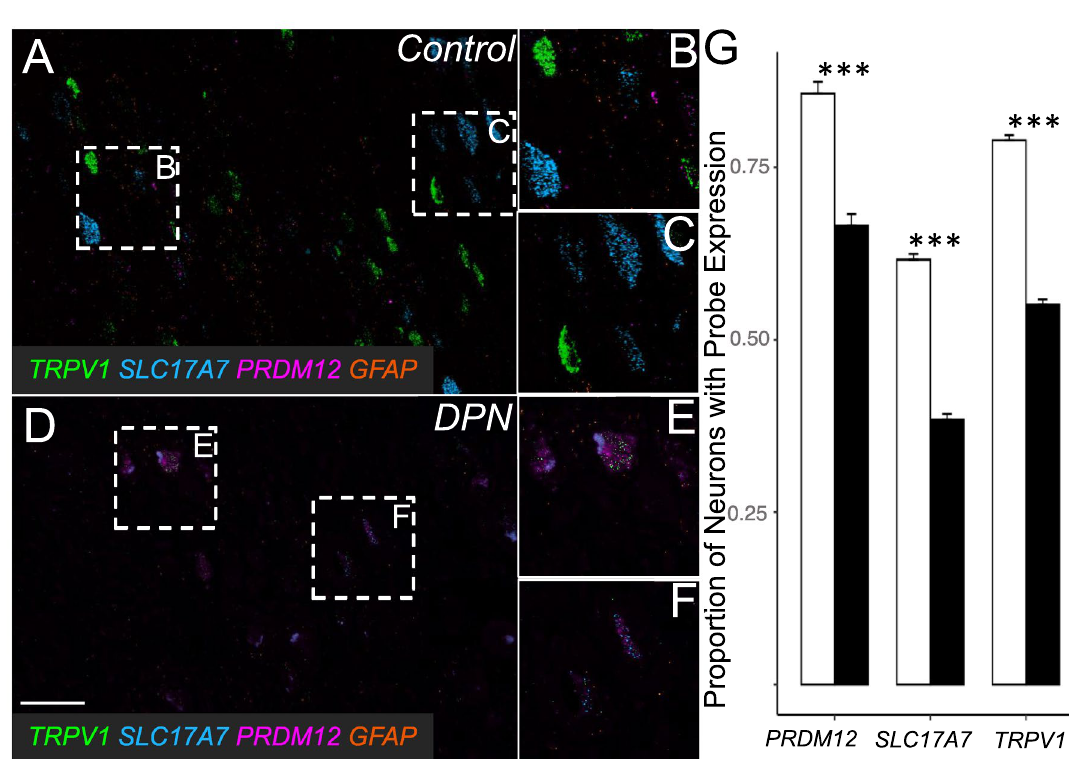
Figure 5. Representative images and comparison of RNAscope data: RNAscope data confirms a loss of neuronally related genes as noted in RNA-seq results by demonstrating a decrease in the proportion of neurons expressing each neuronal probe. ( A ) DRG of non-diabetic individuals displayed ( B ) small diameter TRPV1 positive neurons and ( C ) larger diameter SLC17A7 positive neurons. ( D ) DRG of DPN individuals had decreased proportions of neurons expressing all three probes, while still containing expected neuronal subtypes such as ( E ) small TRPV1 positive and ( F ) larger SLC17A7 positive neurons. Scale bar = 100 µm. ( G ) Differences in proportion of neurons expressing each RNAscope between control and DPN tissue were significant at the ***p < 0.0001 level, according to the Cochran-Mantel–Haenszel Test ( TRPV1 and SLC17A7 ), and Fisher’s Exact Test ( PRDM12 ). Each probe was significantly downregulated, evidence of a loss of neuronally related gene expression in DPN DRG. Data is shown graphically as mean and standard error. The downregulated expression of these three neuronal markers coincides with the neuronal loss seen histologically. Although dedifferentiation could cause a loss of TRPV1 + and SLC17A7 + neurons, most neurons were still labelled with either of these two markers. White and black bars represent the control and DPN neurons expressing RNAscope,